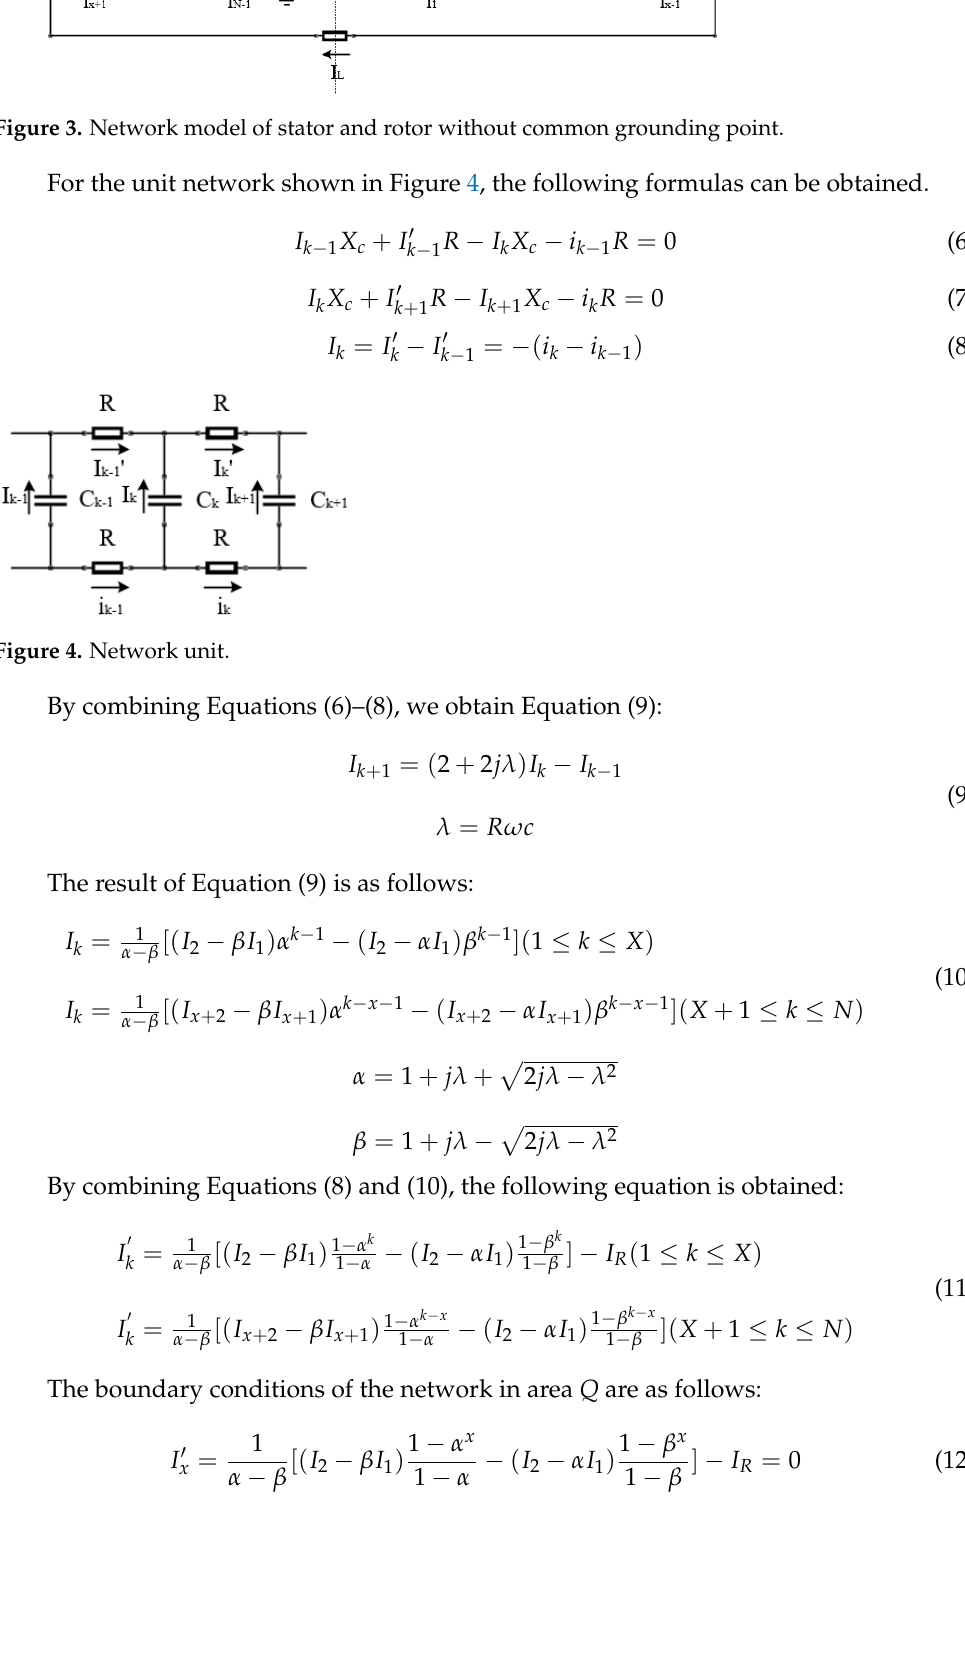
Figure 3. Network model of stator and rotor without common grounding point.